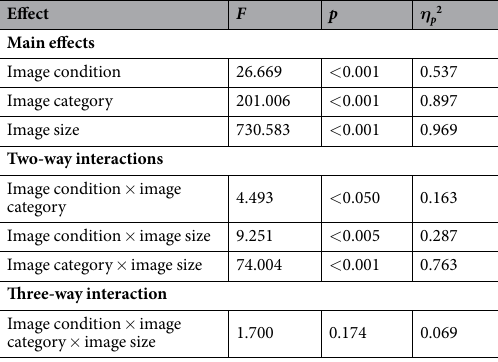
Table 3. Results of the 2 × 3 × 5 (image condition × image category × image size) ANOVA for the central tendency in the vertical direction.